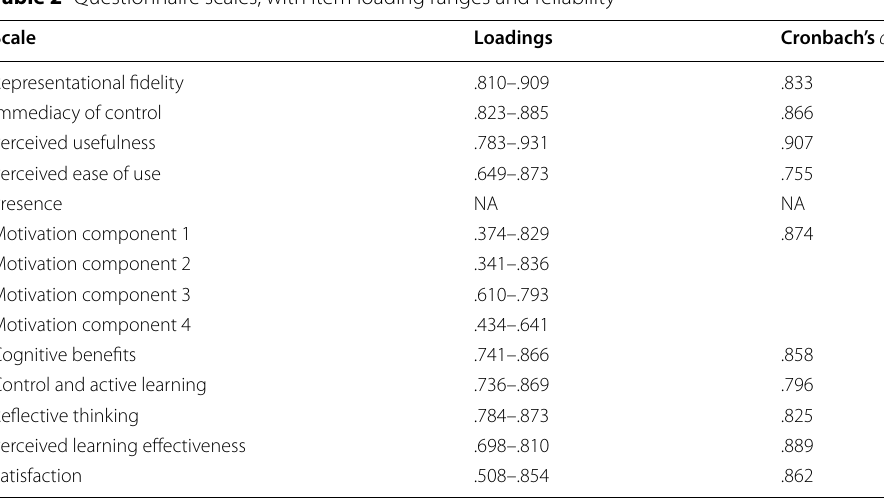
NA Not applicable, treated as single‑item =